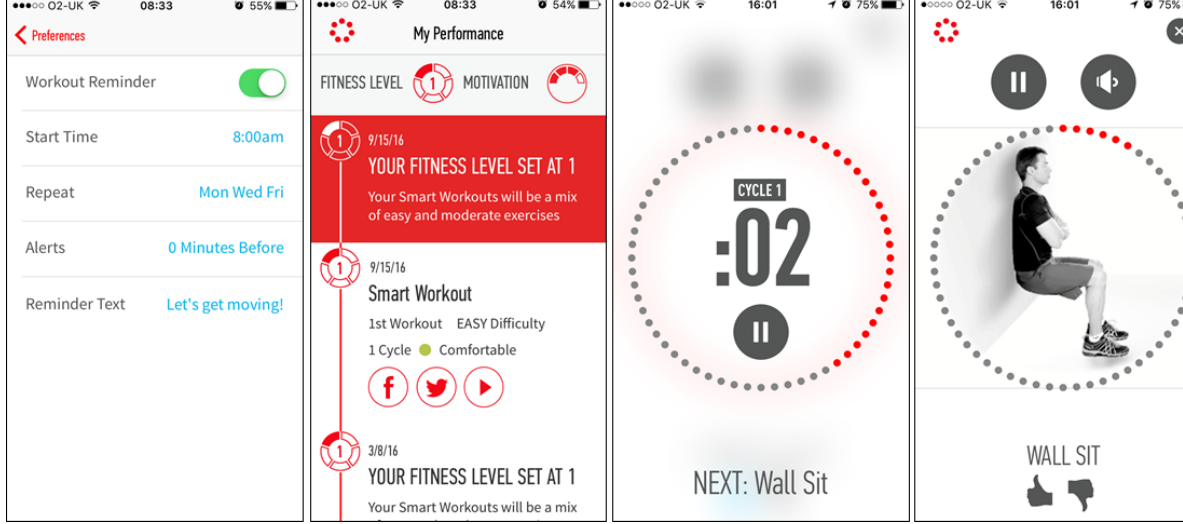
Figure 3. Screenshots of The Johnson & Johnson Official 7 Minute Workout (J&J).